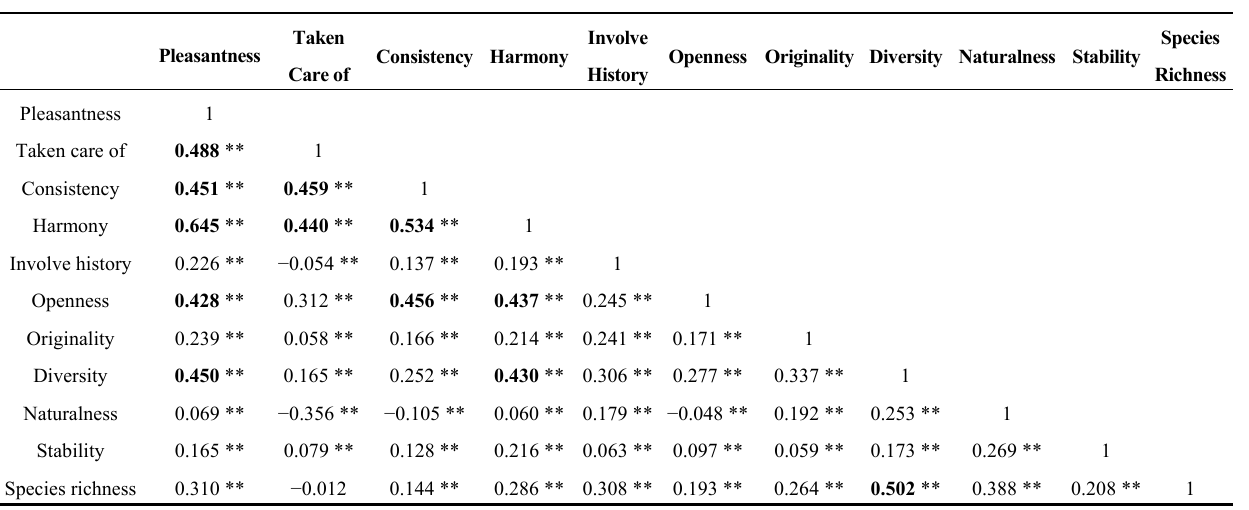
Table 2. Spearman correlation coefficients between 11 landscape evaluation scales. Taken Pleasantness Care